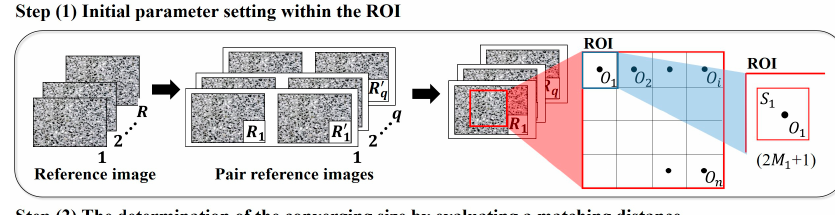
and 𝑞𝑞′ are the pair reference images. 𝑅𝑅 𝑞𝑞 𝑅𝑅